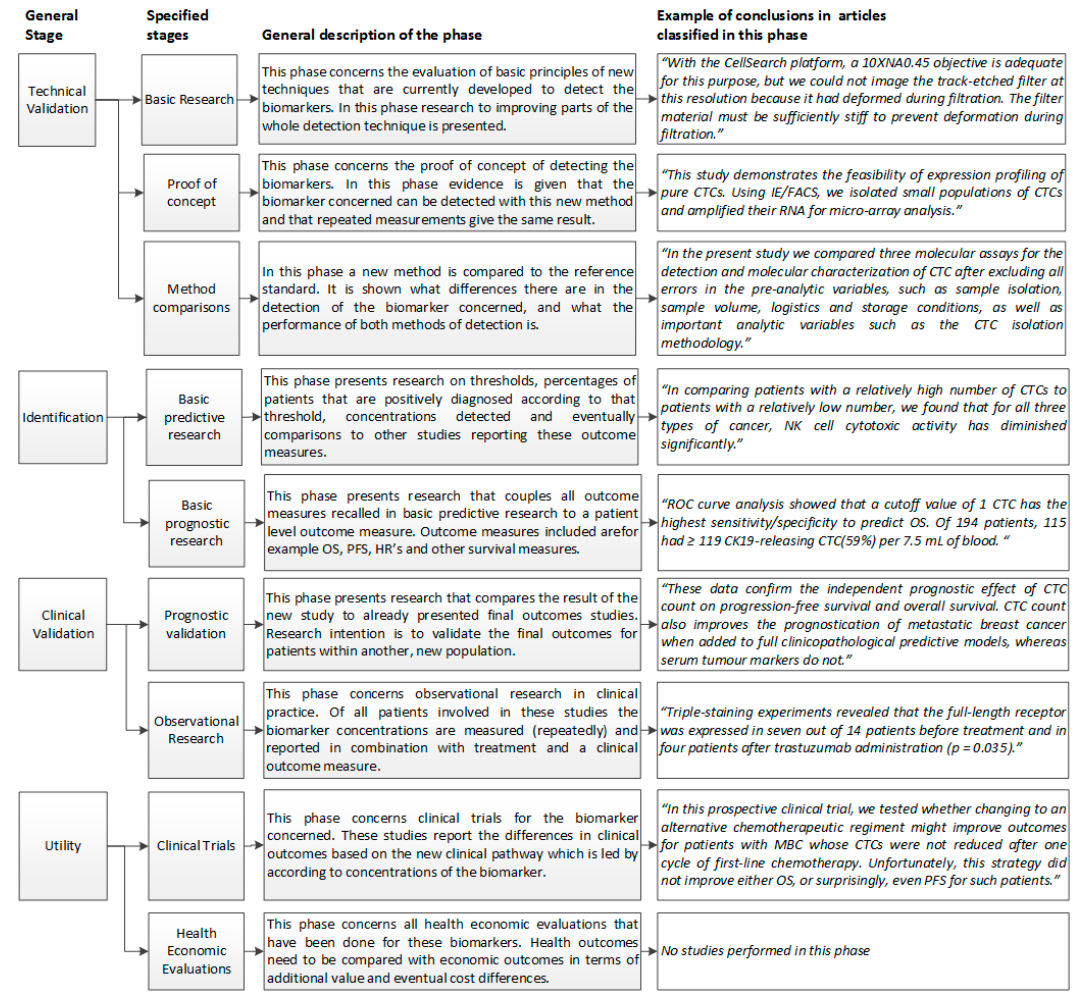
Figure 2. Stages of clinical translation in biomarker discovery [14–21].